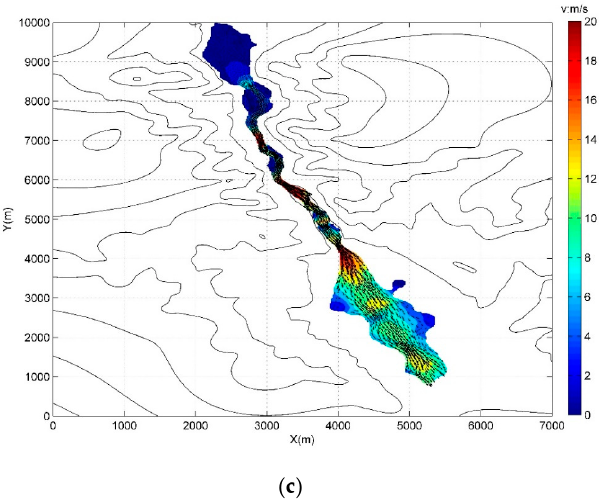
Figure 16. Flow velocity fields under breach ratio 100% at different time instants: ( a ) t = 200 s; ( b ) t = 400 s; and ( c ) t = 600 s.